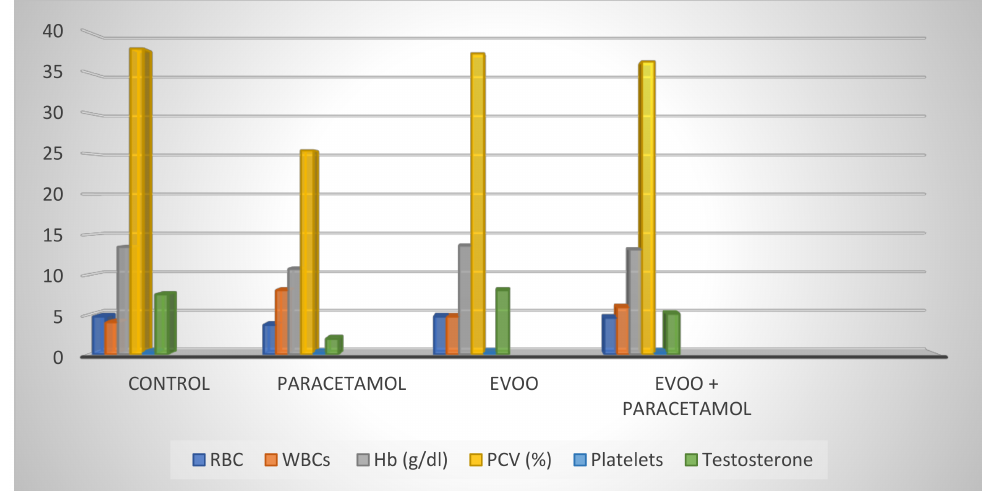
Data represented as mean ± SE. Different superscripts are significant. p : p value for F test (ANOVA) and significant between groups using post hoc test (LSD) *: Statistically significant at p ≤ 0.05 concentration in male rats. The values are expressed as means ± S.E ( n = 5), significant difference at p < 0.05.